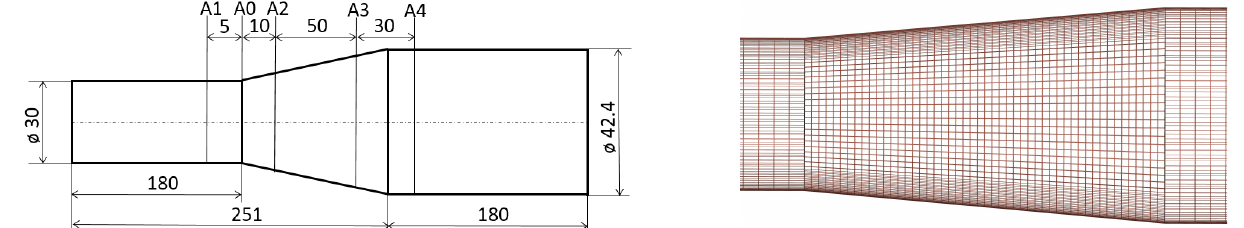
Figure 14. Computational model geometry (dimensions are given in mm) and grid fragment in the diffuser area.